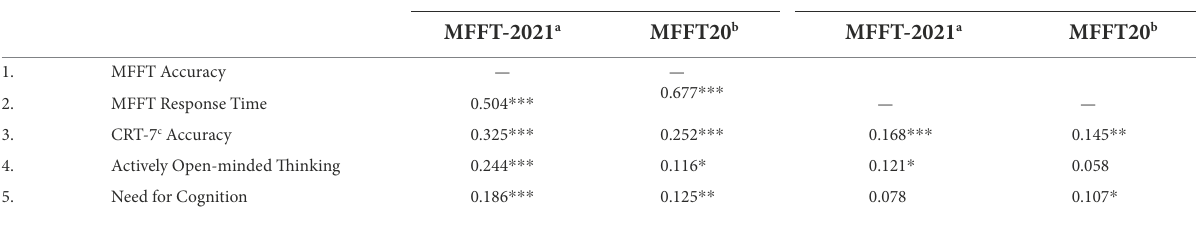
TABLE 3 Comparison of MFFT correlations by version.